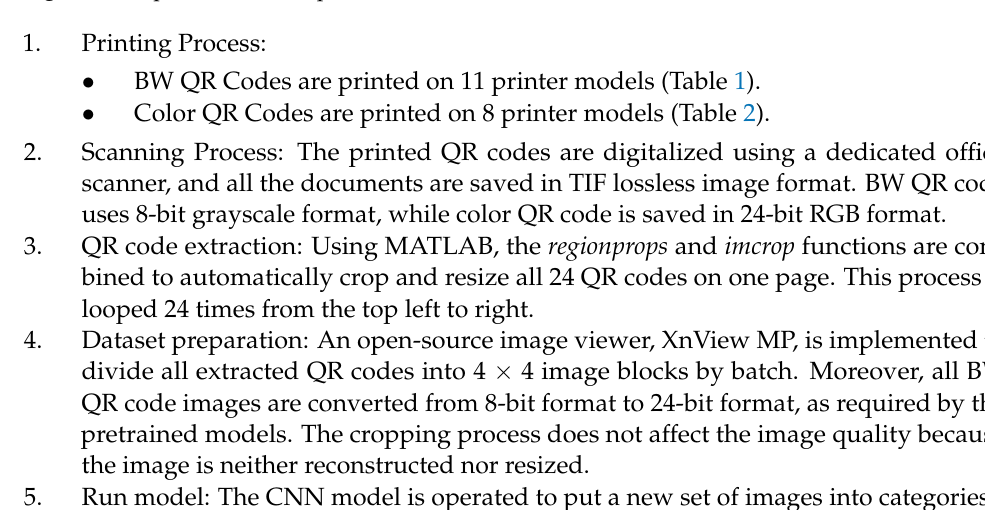
identification of the QR codes.